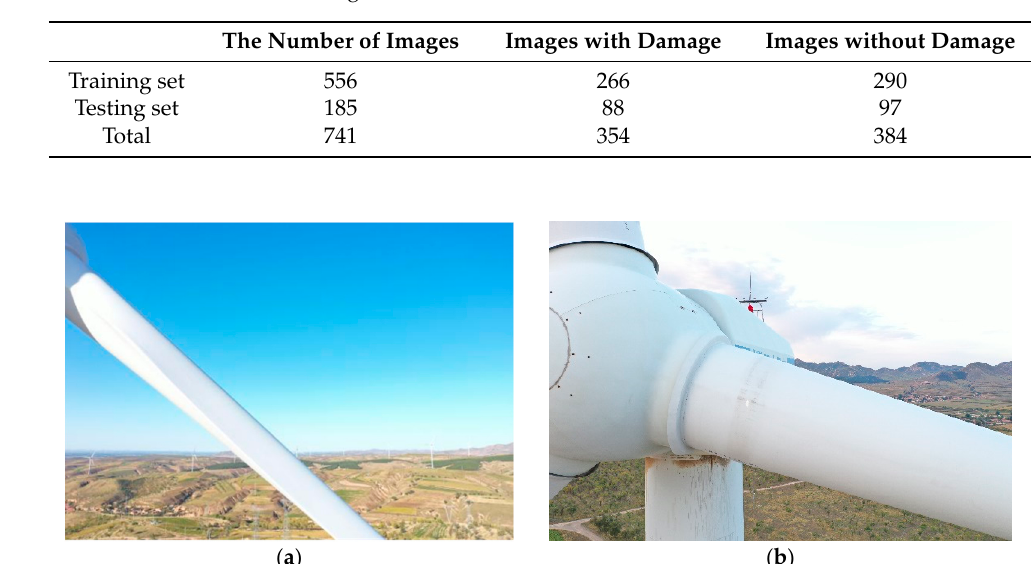
Table 1. The details of the image dataset.